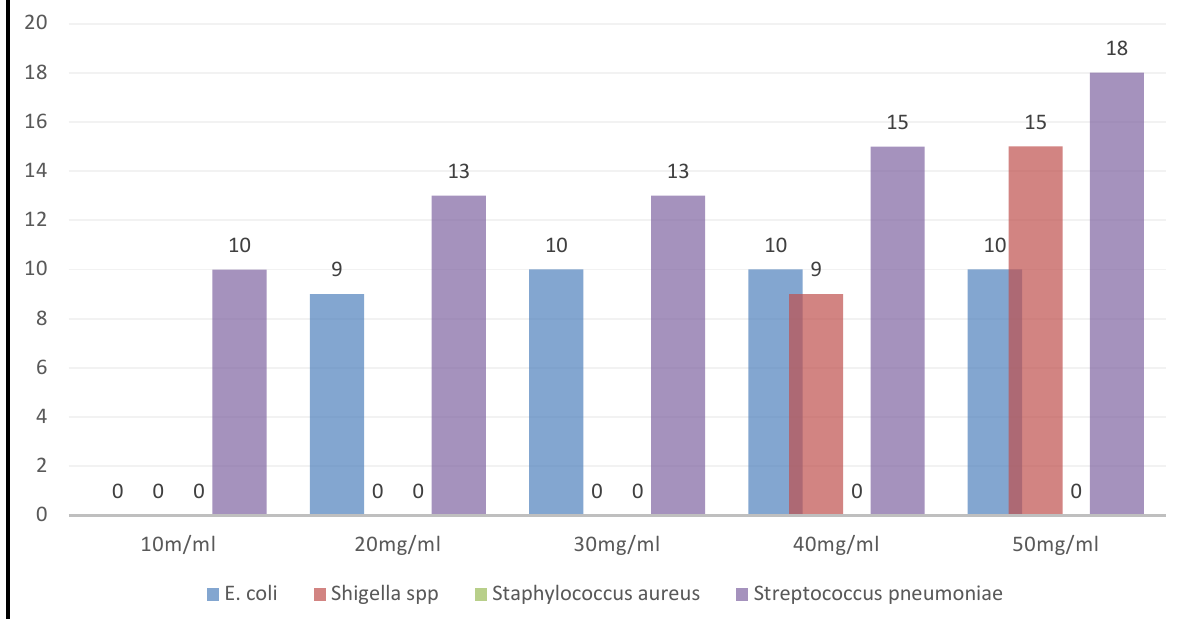
Figure 2. Chart showing zone of inhibition of aqueous extract of Moringa oleifera against the organisms